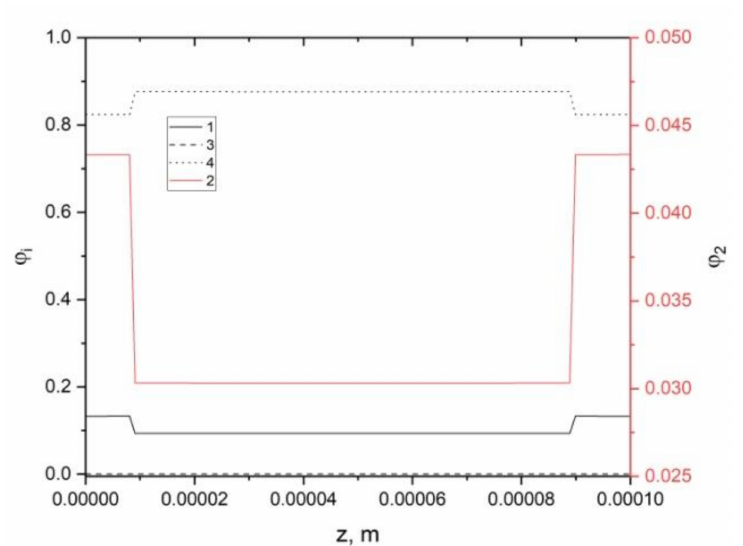
Figure 14. Distribution of volume fractions of phases under the influence of a low-intensity surface forest fire depending on the thickness of the leaf at time t = 5 s (summer, July, +20 ◦ C, ϕ 30 = 0.3, α s = 0.05): 1—dry organic matter, 2—soot particles, 3—moisture,